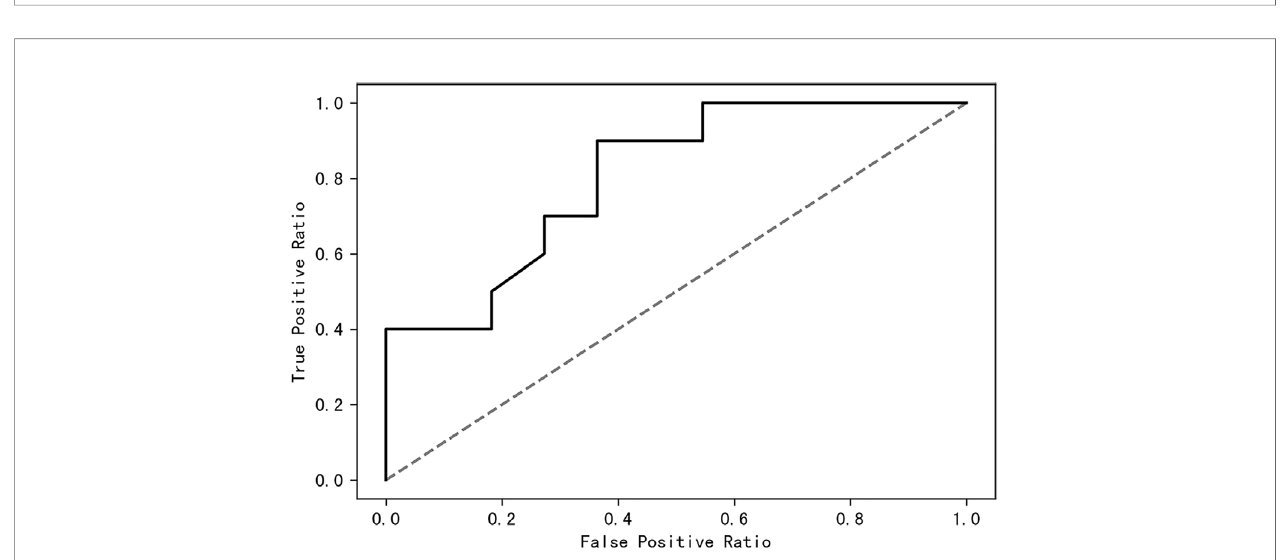
FIGURE 8 | The top 10 species of contribution were used to construct a random forest model with an AUC of 0.87. AUC, area under the